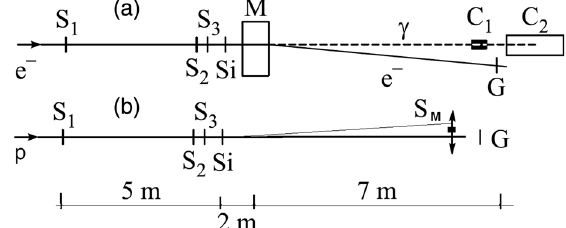
FIG. 3. Schematic of the crystal setup: ( S 1 – S 3 ) scintillation counters, (G) hodoscope for the determination of particle coor- dinates, (Si) crystal in the goniometer. (a) For electron beam: ( C 1 , C 2 )calorimetersforthedeterminationoftheenergyofphotons, (M) magnet. (b) For proton beam: ( S M ) the scanning